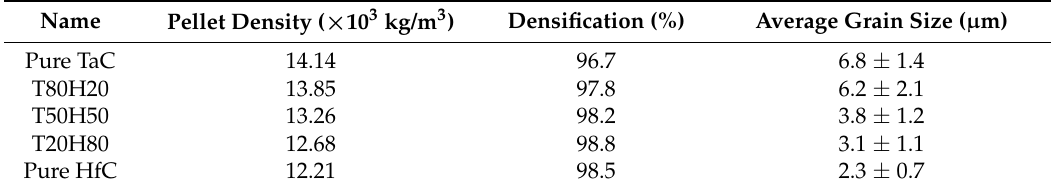
Table 1. Basic characterizations of the TaC, HfC, and TaC-HfC solid